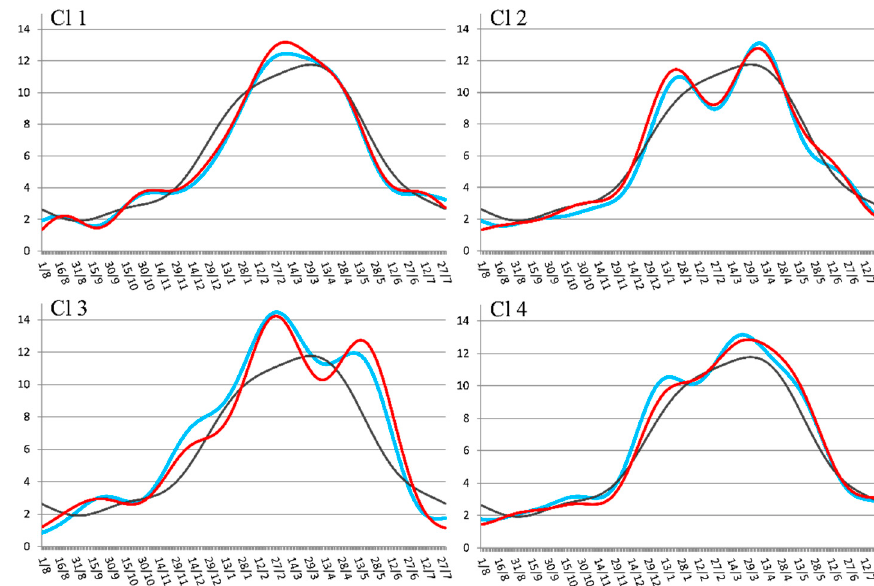
Figure 11. Rainfall sub-regimes Cl1 to Cl4, in the northeastern region of AB from rain gauge (blue line), 3B42 pixel (red line), and mean annual regime of the region from rain gauge (grey line). Table 3. Rain gauge and 3B42 mean annual rainfall (in mm) for each rainfall sub-regime of the northeastern region.